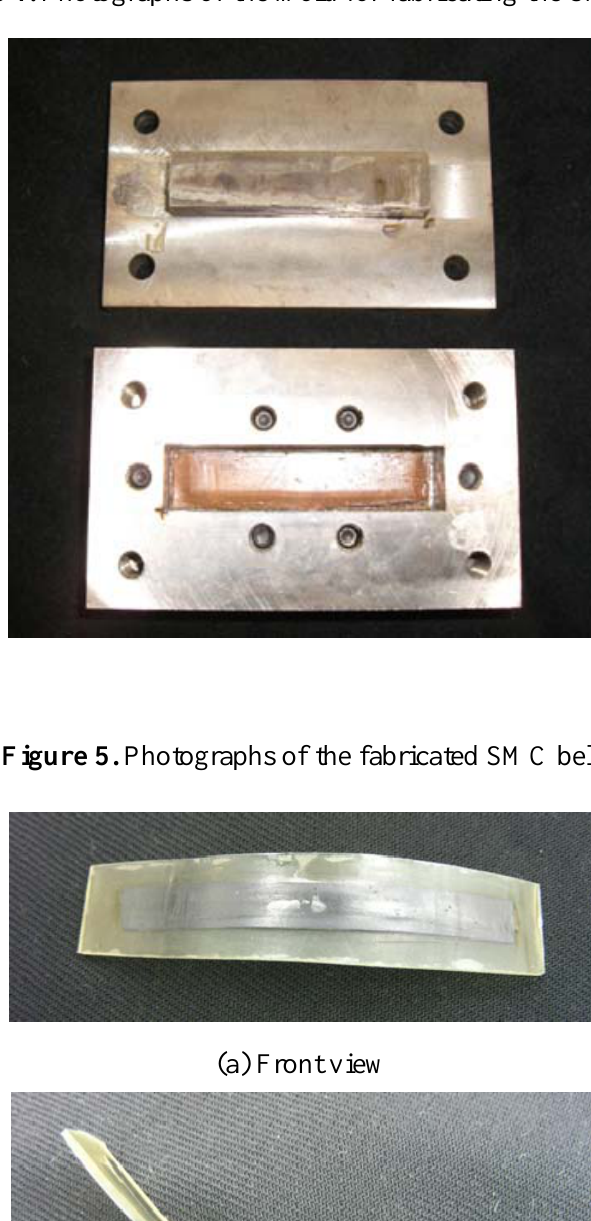
Figure 4. Photographs of the mold for fabricating the SMC belt.